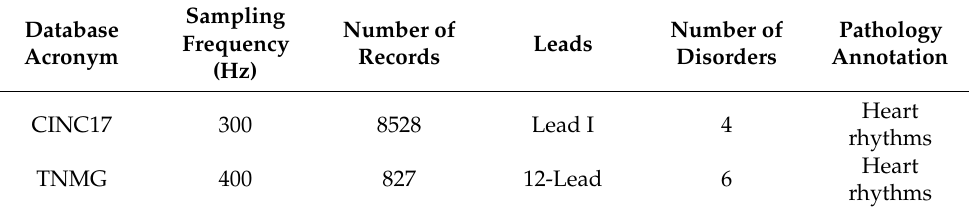
Table 1. ECG Database